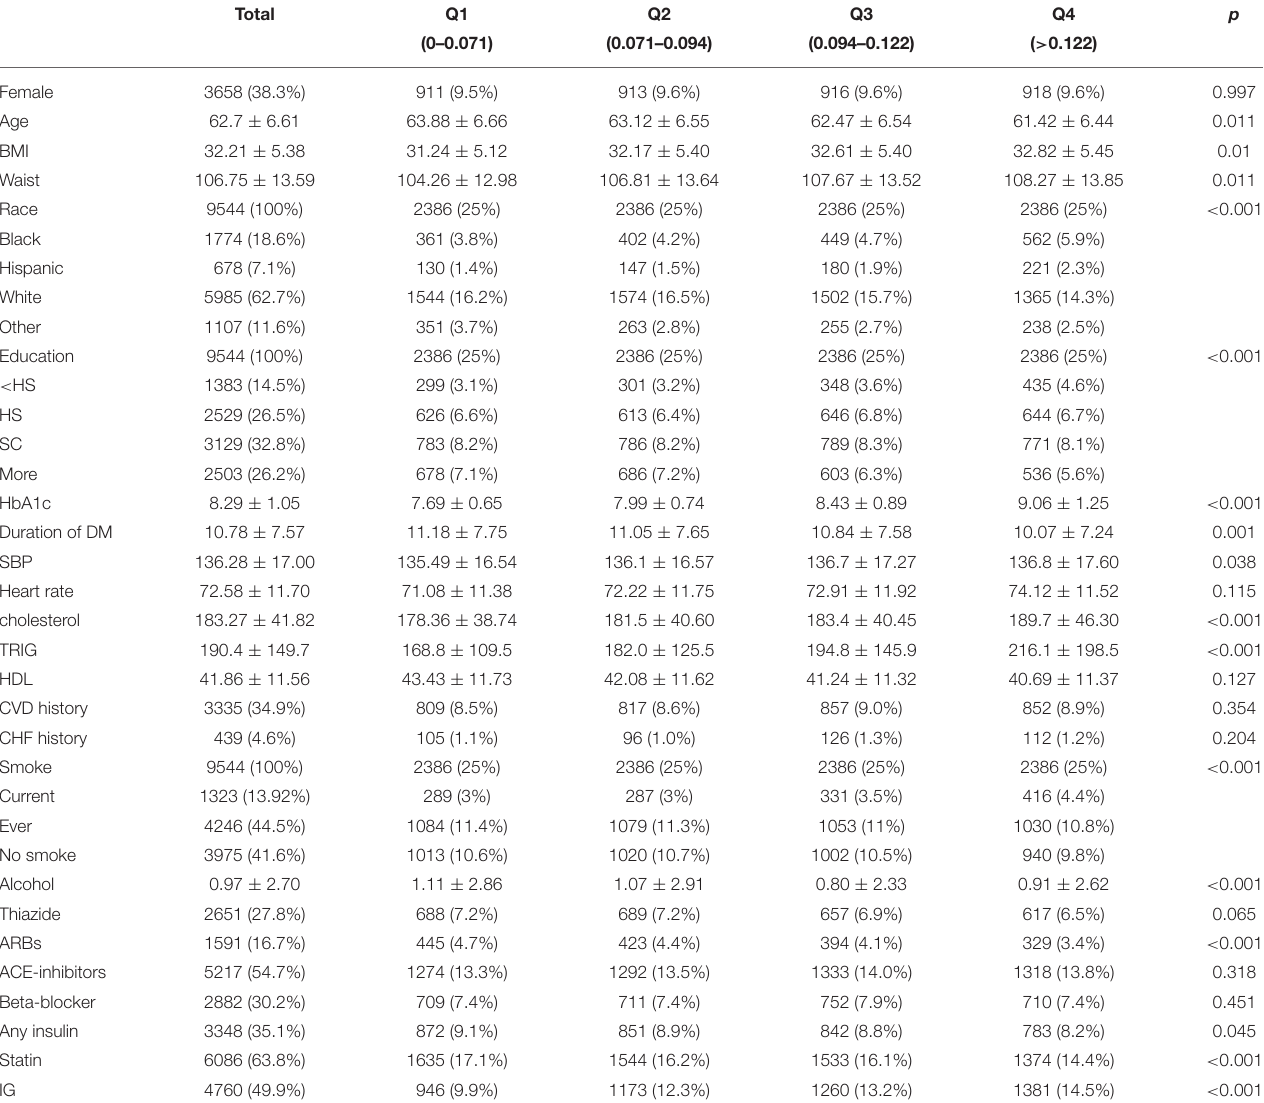
TABLE 1 | Baseline characteristics grouped by quartiles of variability of